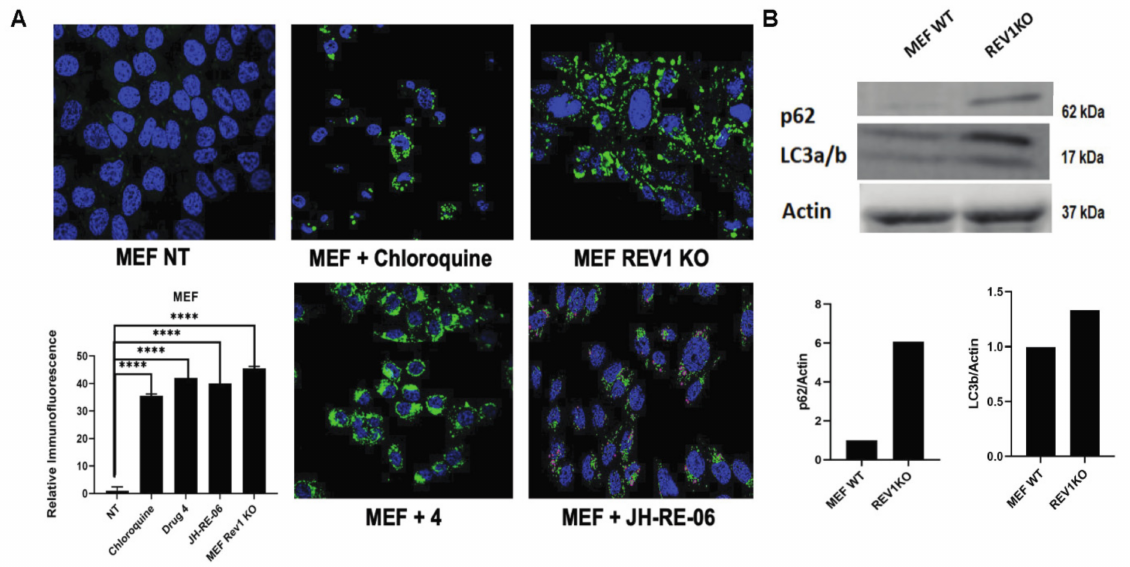
Figure 3. REV1 inhibition triggers autophagy. ( A ) Immunofluorescence images show autophagy flux (green) in MEF WT cells treated with chloroquine (positive control), drug 4 (7922759), and JH-RE-06, with REV1KO cells as validation controls. The graph shows relative quantification of the cells expressing the green fluorescence signal. p -Values are **** p < 0.0001. Error bars represent standard deviations. p -Values were calculated by t -test. N ≥ 50. Images are at 40 × . ( B ) Representative image of a Western blot showing expression of p62 and LC3a in MEF REV1 KO cells compared to the WT MEF. Graph shows relative